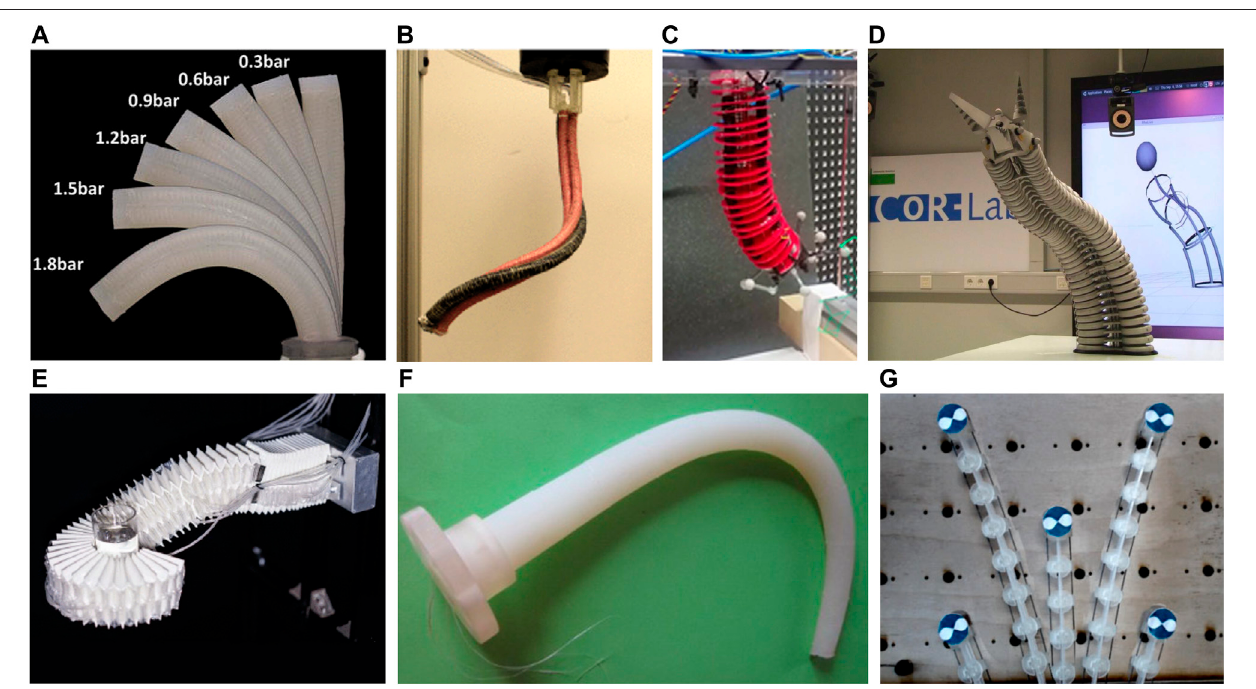
FIGURE1| Continuumrobotsdrivenby (A – E) pneumaticsor (F-G) tendons.Imagesourcesfor (A) – (G) insequence:(Leeetal.,2017a;Satheeshbabuetal.,2019; Ansari et al., 2017a; Rolf and Steil, 2013; Jiang et al., 2016; Giorelli et al., 2015a; Yip and Camarillo, 2014).